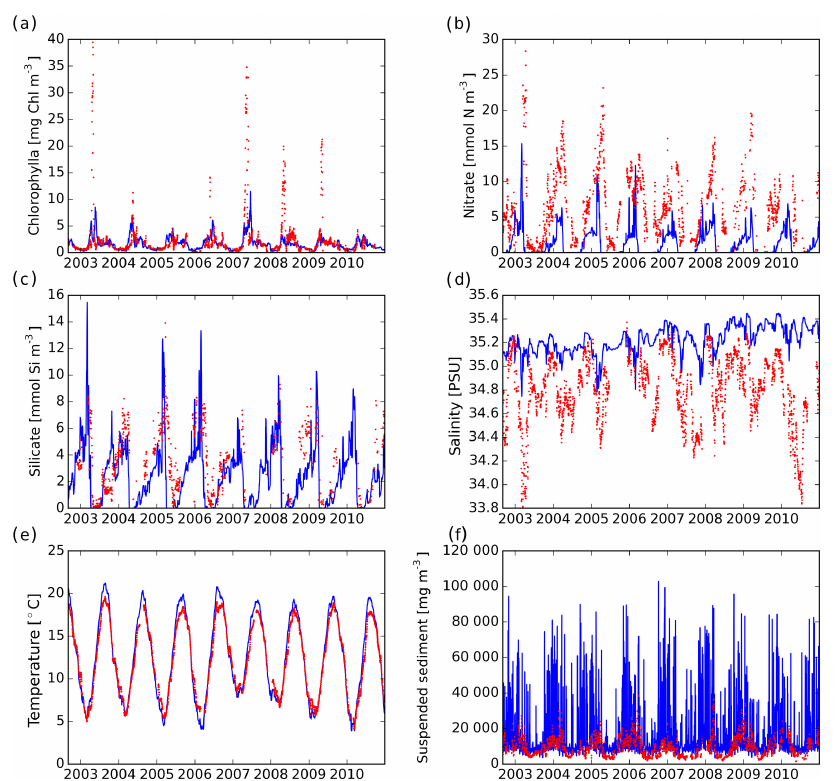
Figure 8. Time series comparison with west Gabbard SmartBuoy at the surface. Blue: model; red: observations. (a) Chlorophyll- a concen- tration; (b) nitrate concentration; (c) silicate concentration; (d) salinity; (e) temperature; (f) suspended sediment concentration. Table 6. Simulated farm yields at harvest at the end of July (10 3 kgC; 10 3 kg wet biomass between brackets; factor of 24.919). Farm size 2006/2007 2010/2011 (per metre of